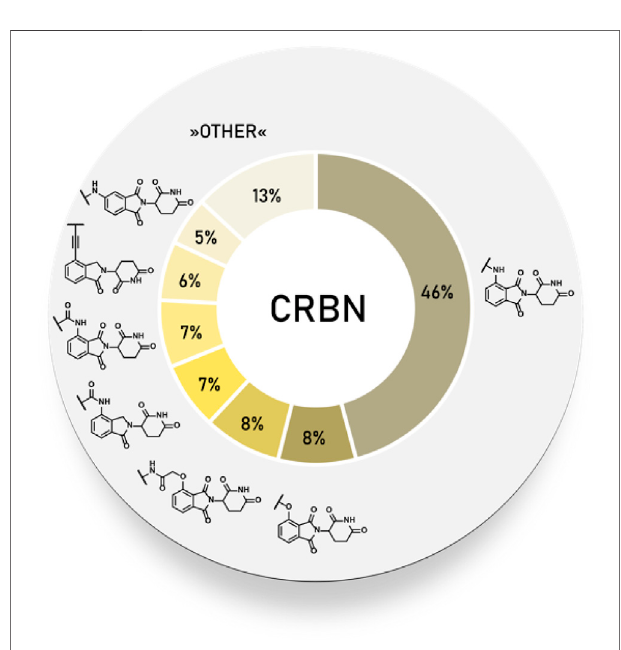
FIGURE 3 | Frequency of CRBN ligands used in PROTAC